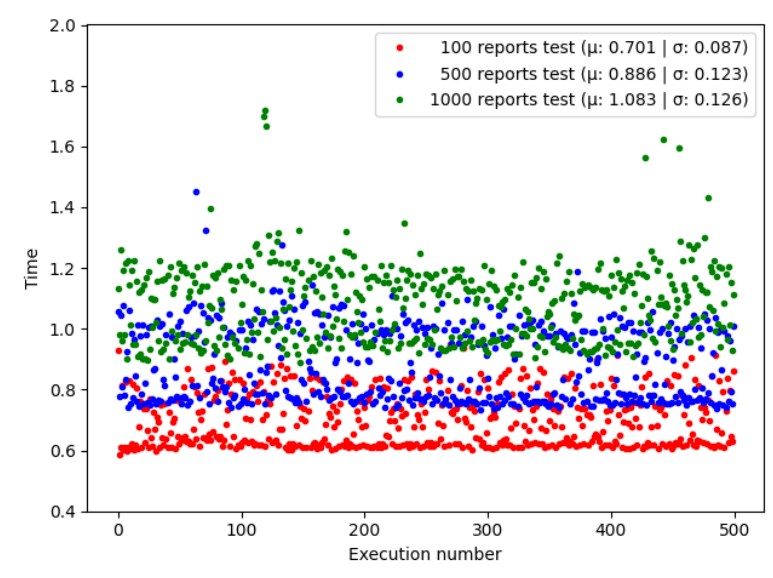
Figure 6. Comparison of time required to query multiple reports at once: Date. Table 2. Comparison of mean and standard deviation in every